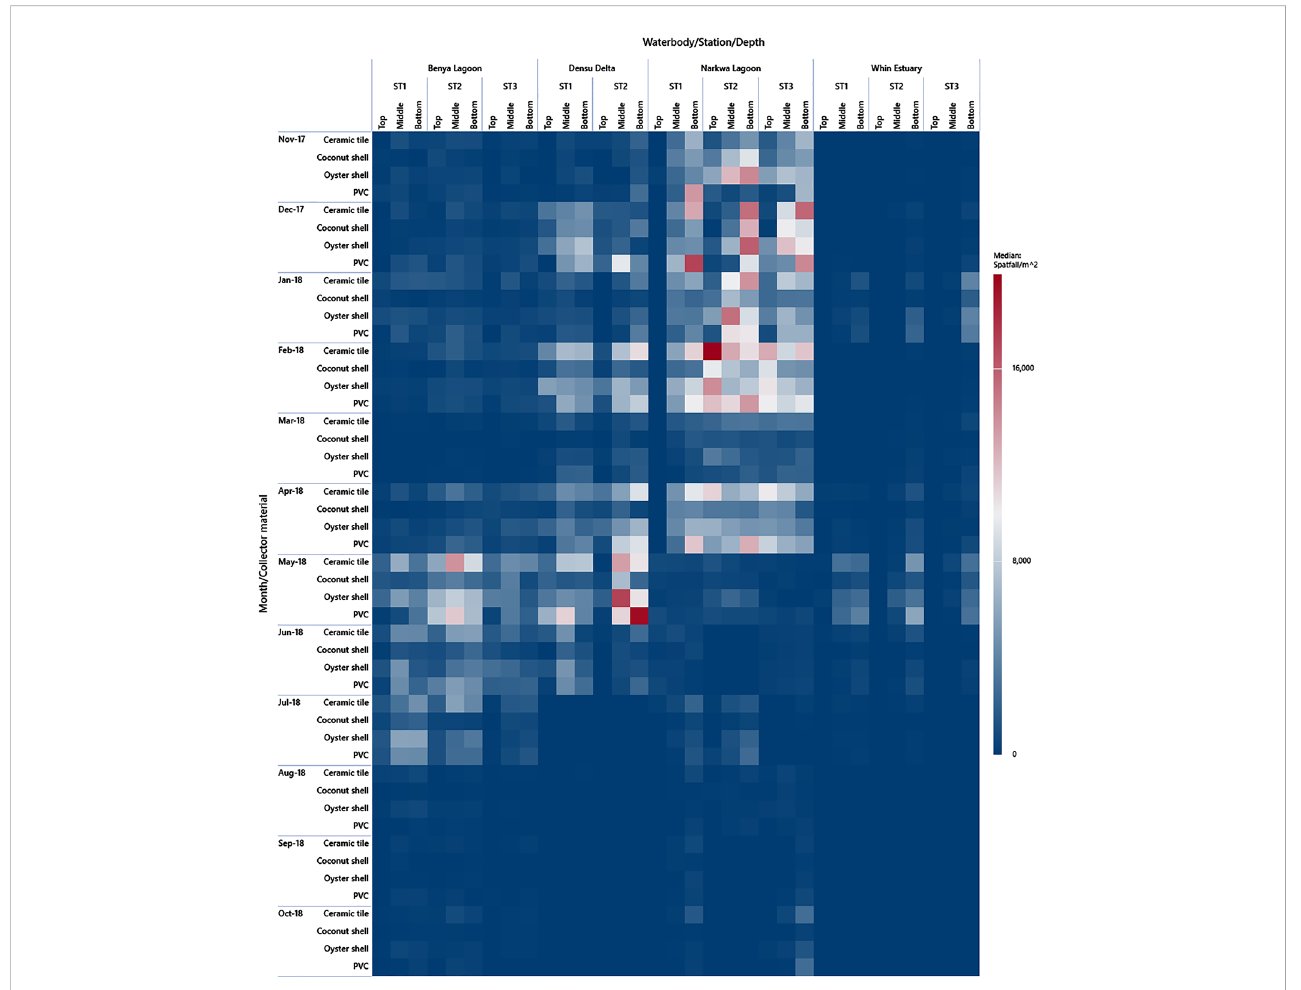
FIGURE 9 Heat map plot of spat availability in the brackish systems by season (dry season = Nov-17 to April-18; wet season = May-18 to Oct-18) and by the depth at stations in the water bodies. Individual spat collector spatfall estimates are used for this graph to give a detailed chequer of the heatmap. The results of the effectiveness of the different collectors are published in Chuku et al. (2020). Note that Station 3 of Densu Delta was eliminated from the